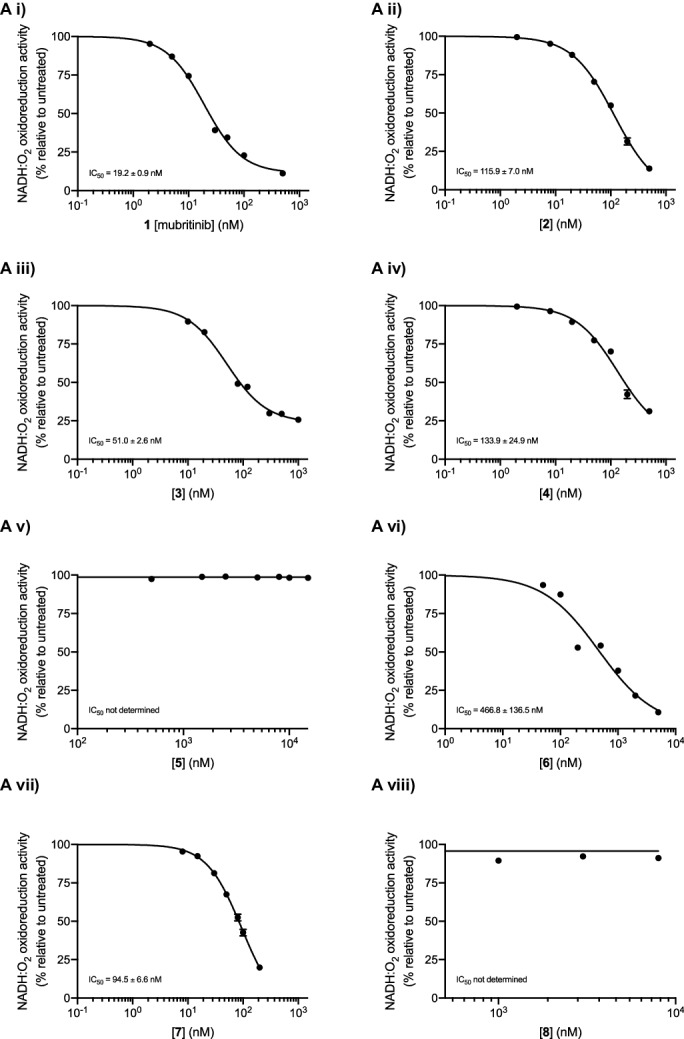
Complex I inhibition by mubritinib and the synthesised variant compounds.(A) Mubritinib and the compound variants (i-viii) were incubated with mitochondrial membranes at the concentrations shown. The rate of NADH oxidation was measured spectrophotometrically, and data were fit to the standard dose-effect relationship (activity (%) = 100/(1 + (IC50 / [inhibitor])Hill slope). The activity is expressed relative to the DMSO control, set to 100%. For each compound the IC50 values (nM) measured on mitochondrial membranes are shown with standard errors (n = 3).